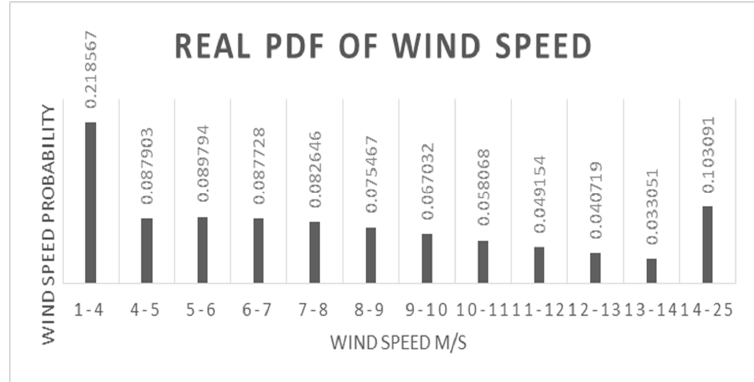
Figure 3. Wind probability distribution.